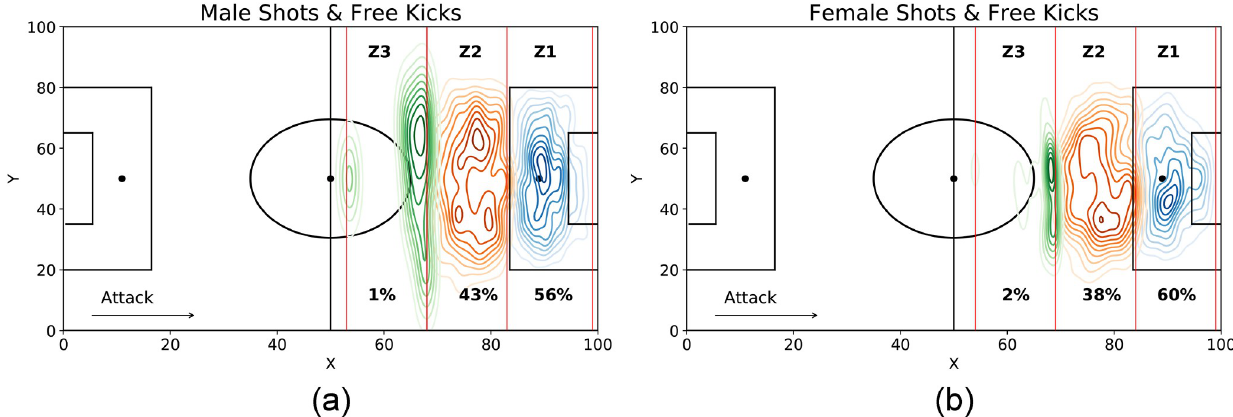
Fig 3. Pitch zones from where free-kicks and shots in motion are more likely to be made by male players (a) and female players (b). We split the attacking midfield into three equal zones: Z 1 is the area closest to the opponents’ goal, Z 3 the furthest, and Z 2 the zone in the middle. In each zone, we show the percentage of free kicks and shots in motion made in that zone and depict the kernel estimate of the First Grade Intensity function, where the event points are the free-kicks and the shots in motion, and the football field is the region of interest. The darker the color, the higher is the number of events in a specific field position. Female zones are 1.1 meters closer to the opponents’ goal than male